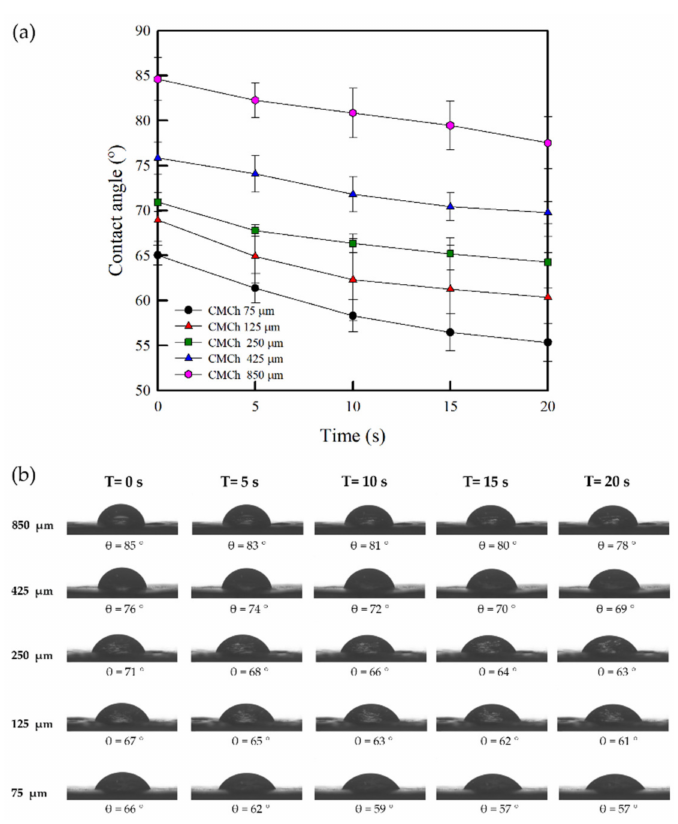
Figure 8. Dynamic contact angle measurement of the CMCh films ( a ) and contact angle images of a 10 µ L water droplet on the surface of the CMCh films with times ( b